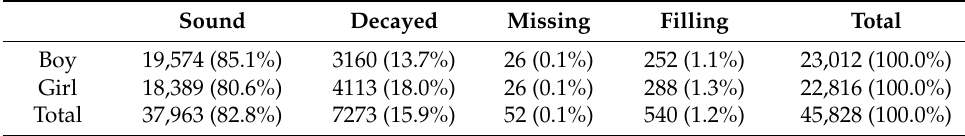
Table 1. Status of sound, decayed, missing and filled PFMs by gender [n (%)]. Sound